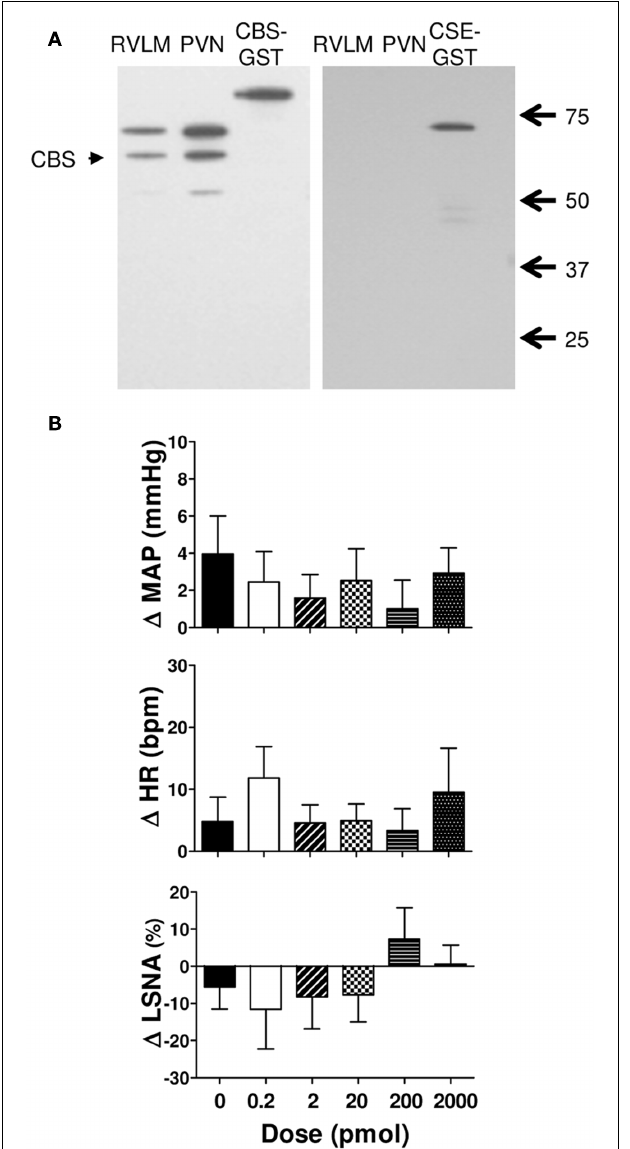
FIGURE 1 | (A) Western blot showing expression of cystathionine- β -synthase (CBS) and cystathionine- γ -lyase (CSE) in punched out homogenates of the rostral ventrolateral medulla (RVLM) and hypothalamic paraventricular nucleus (PVN).The 63kDa band corresponding to CBS protein was labeled in both PVN and RVLM samples. No CSE was observed in the PVN or RVLM.The GST-tagged CBS (86kDa) and GST-tagged CSE (70kDa) are shown.The native CSE protein is 44kDa. (B) Changes in mean arterial pressure (MAP), heart rate (HR), and lumbar sympathetic nerve activity (LSNA) following vehicle ( n = 13 for MAP and HR and n = 6 for LSNA) and the H 2 S donor (NaHS, 0.2–2000pmol/side; n = 8 for MAP and HR; and n = 5 for LSNA) microinjected into the rostral ventrolateral medulla ofWKY rats. Different shaded bars represent a different dose of NaHS as indicated.